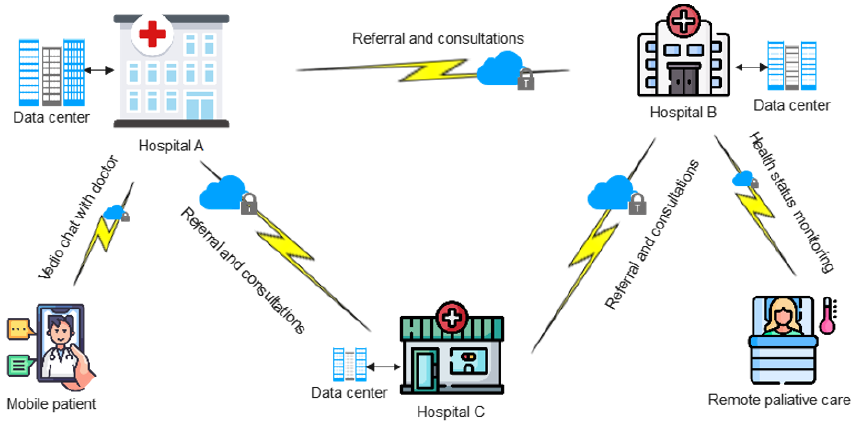
Figure 8. Point-to-Point Links.